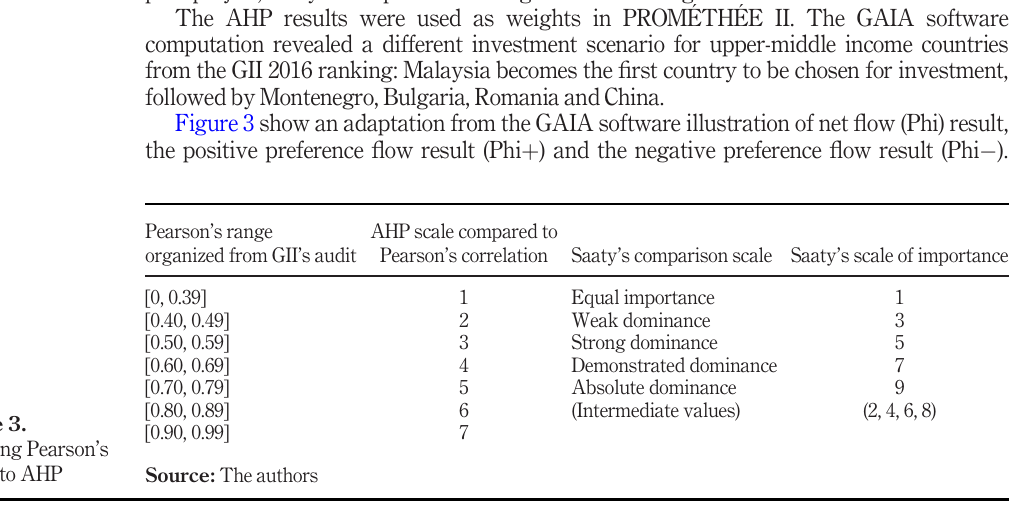
Table 3. Aligning Pearson ’ s range to AHP